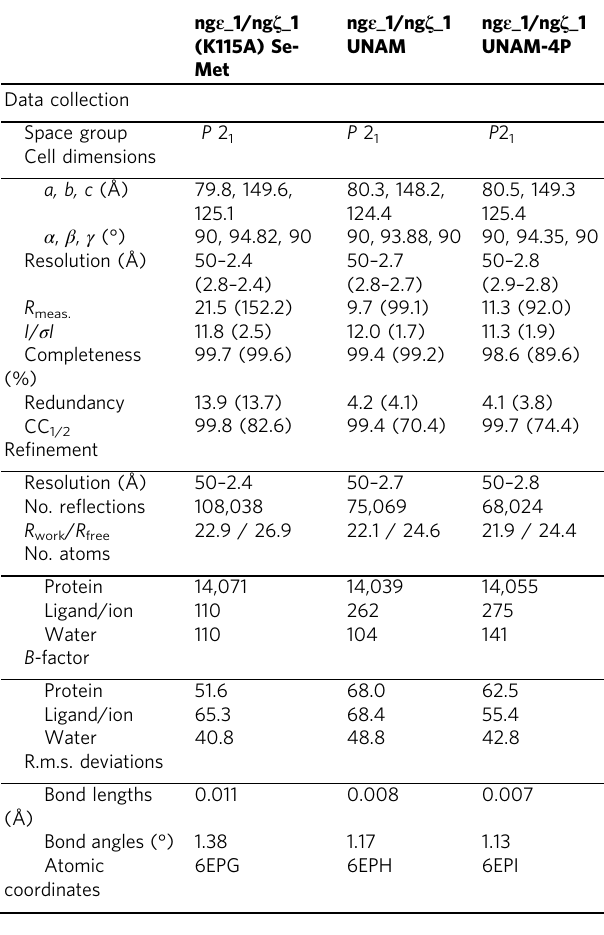
Table 1 Data collection and re fi nement